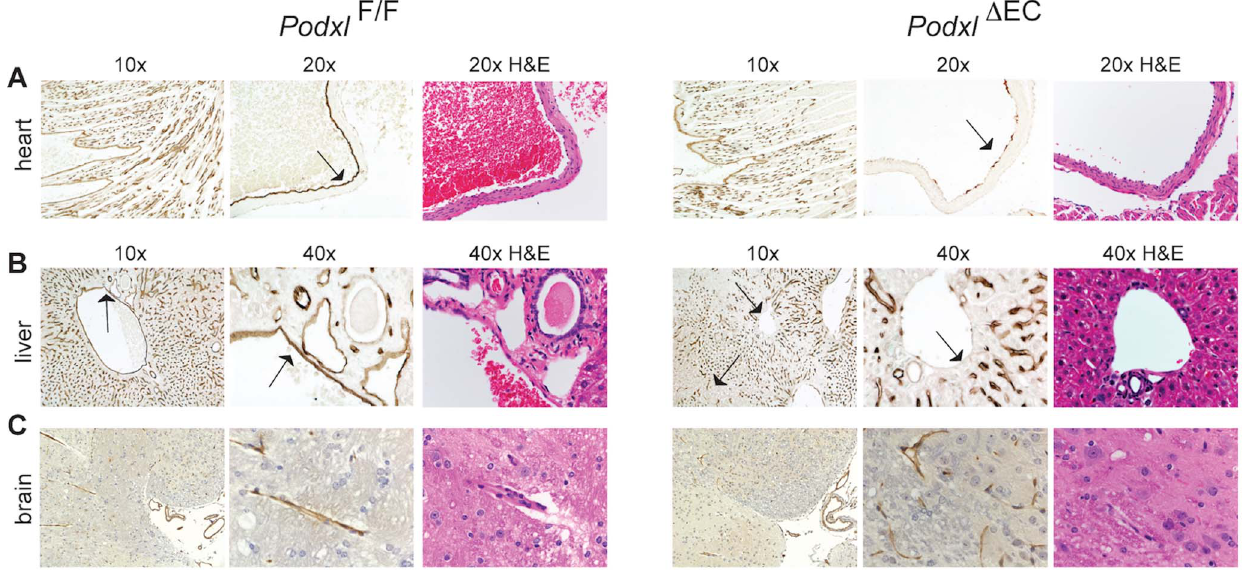
Figure 3. Cdh5 -Cre fails to efficiently delete podocalyxin in a subset of organ vascular beds. ( A ) In the wildtype heart podocalyxin is expressed by all endothelial cells. In the Podxl D EC mice, podocalyxin is efficiently deleted in large vessels such as the pulmonary artery (arrow, 20x mag. panels) but deletion in the smaller trabecular vessels of the heart muscle is variable (see 10x mag. panels). ( B ) In the liver of Podxl D EC mice, podocalyxin expression is ablated in the major vessels (portal and central veins, hepatic artery) but not in sinusoidal endothelial cells. ( C ) In the brain, podocalyxin is normally expressed in the ventricles and endothelial cells, including the microvasculature. Sections of the brain from Podxl D EC mice display similar staining to control mice indicating poor recombination of loxP sites by Cdh5 -Cre in brain. Adjacent H&E sections demonstrate normal gross morphology podocalyxin-deficient tissues.